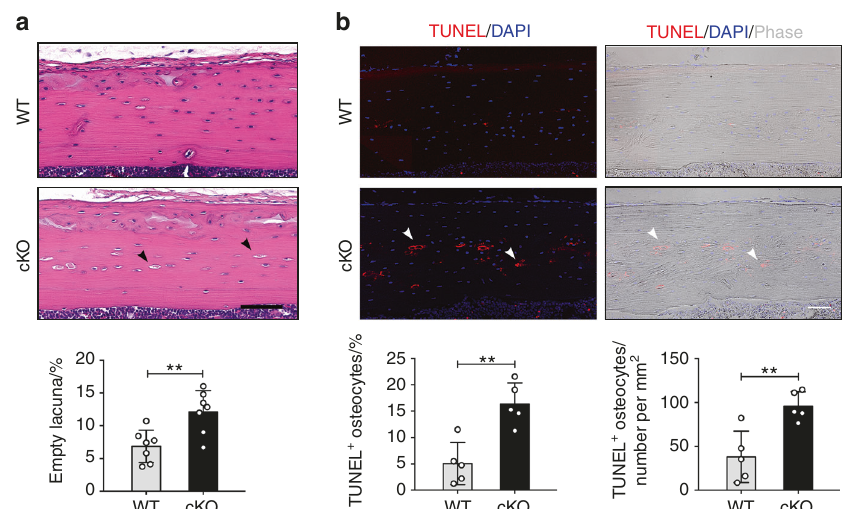
Fig. 2 Deletion of integrin α 5 in osteocytes increased osteocyte apoptosis and empty lacunae in tibial cortical bone. a Representative H&E images and empty lacunae quanti fi cation (black arrows) of tibial midshaft cortical bone in WT and cKO mice. Scale bar: 80 μ m. n = 7 per group. b Representative fl uorescence images of TUNEL-staining (left upper panels) and corresponding phase images (right upper panels). The TUNEL-positive osteocytes are indicated (white arrows). TUNEL-positive osteocytes were quanti fi ed in tibial cortical bone based on total lacunae and bone area (lower panels). Scale bar: 60 μ m. n = 5 per group. Mean ± SD. ** P < 0.01. Student unpaired t